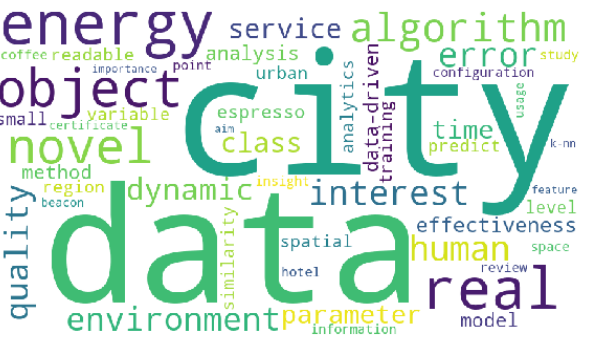
Figure 1. Special issue content: an